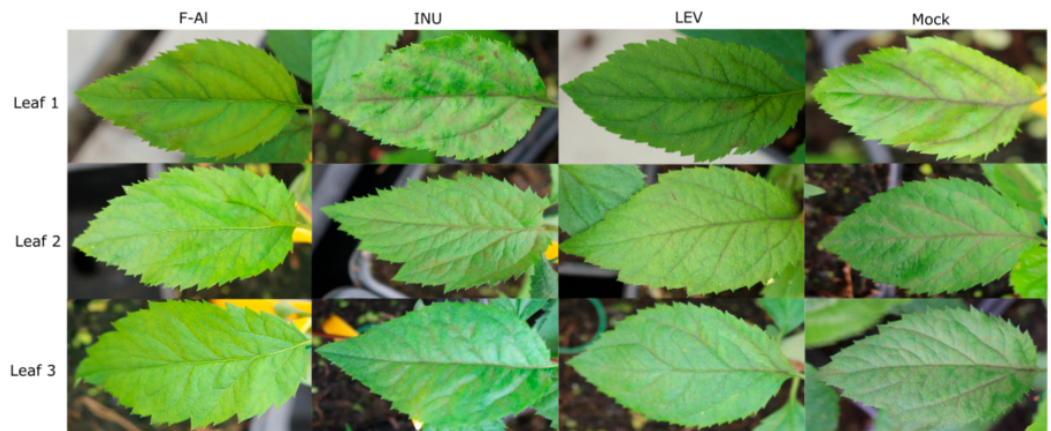
Figure 3. Representative pictures of leaves infected with Venturia inaequalis after treatment with fructans and fosetyl-Al at 14 dpi. F-Al = fosetyl-Al 1.25 g L − 1 , INU = inulin 1 g L − 1 , LEV = levan 1 g L − 1 and Mock = water ‐ treated.